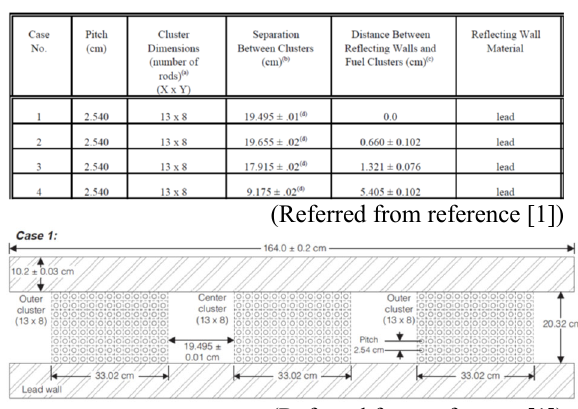
Table 4. Array geometry of LCT-010 cases 1 - 4.